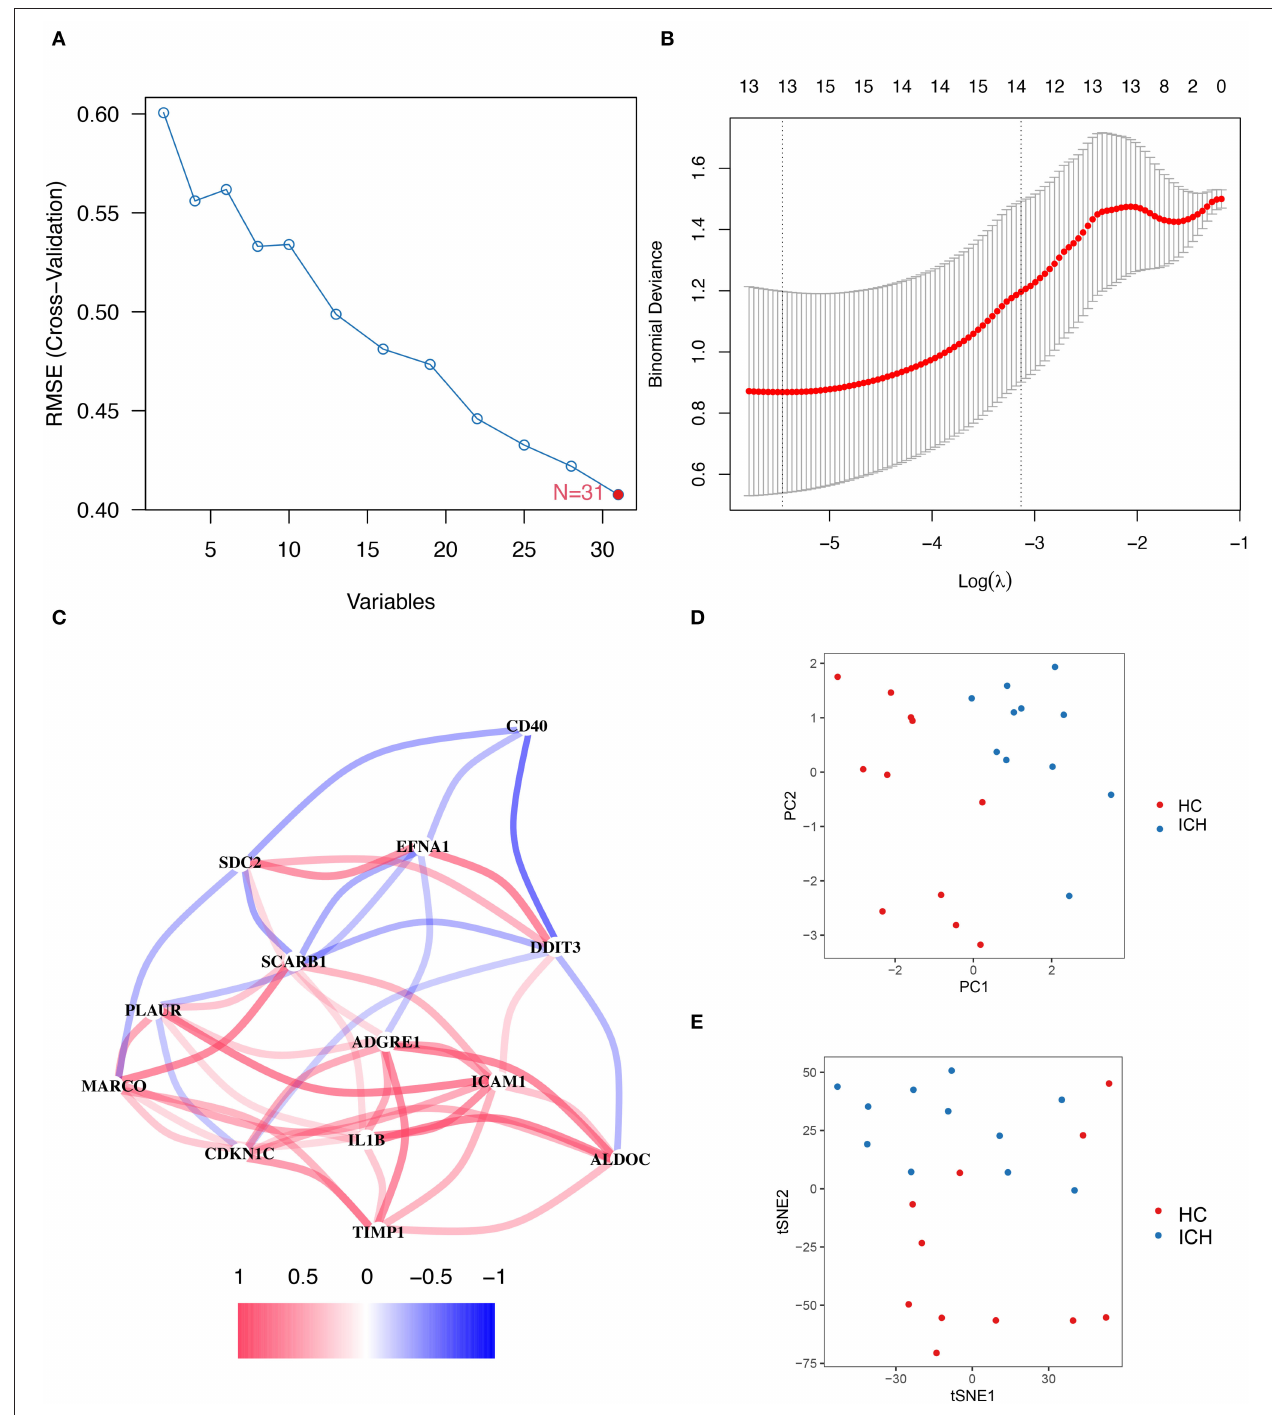
FIGURE 3 | SVM–RFE and LASSO regression analysis results. (A) On a line graph the prediction accuracy of each variable included in the model is displayed. And the SVM–RFE screening process showed the smallest errors were obtained when all 31 genes were included in the model. (B) The LASSO analysis resulted in a final screening of 13 genes. (C) Correlation linkage maps of hypoxia- and inflammation-related genes using machine learning. (D) PCA shows that the visualization of data based on PC1 and PC2 can be clearly distinguish between patients with ICH at different stages. (E) Visualizes the ability to distinguish patients with ICH at different stages of development by tSNE